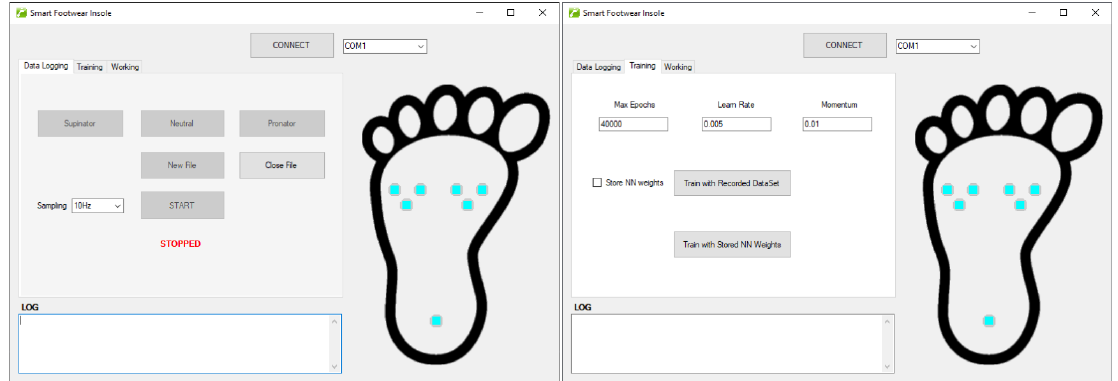
Figure 6. User Application 1: ( left ) Monitoring and Data storing, ( right ) Training.